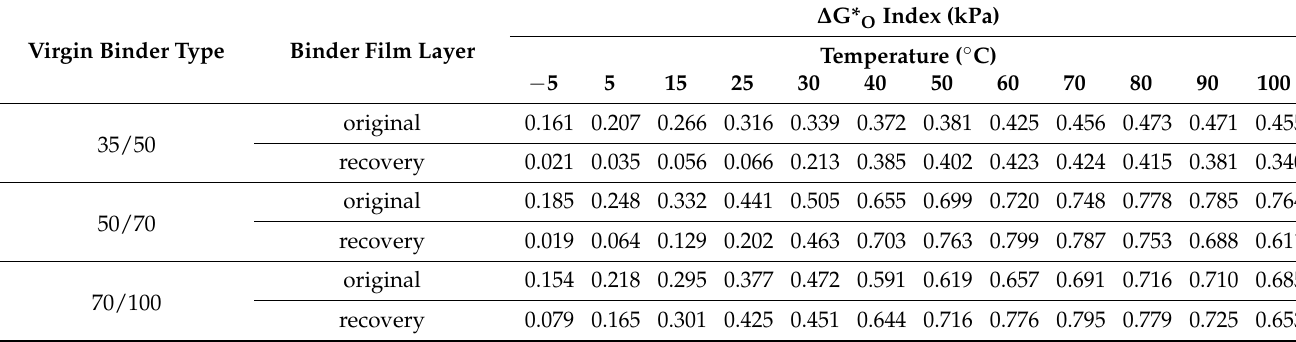
Table 2. ∆ G* O index for the original and after staged extraction-recovered paving bitumens.